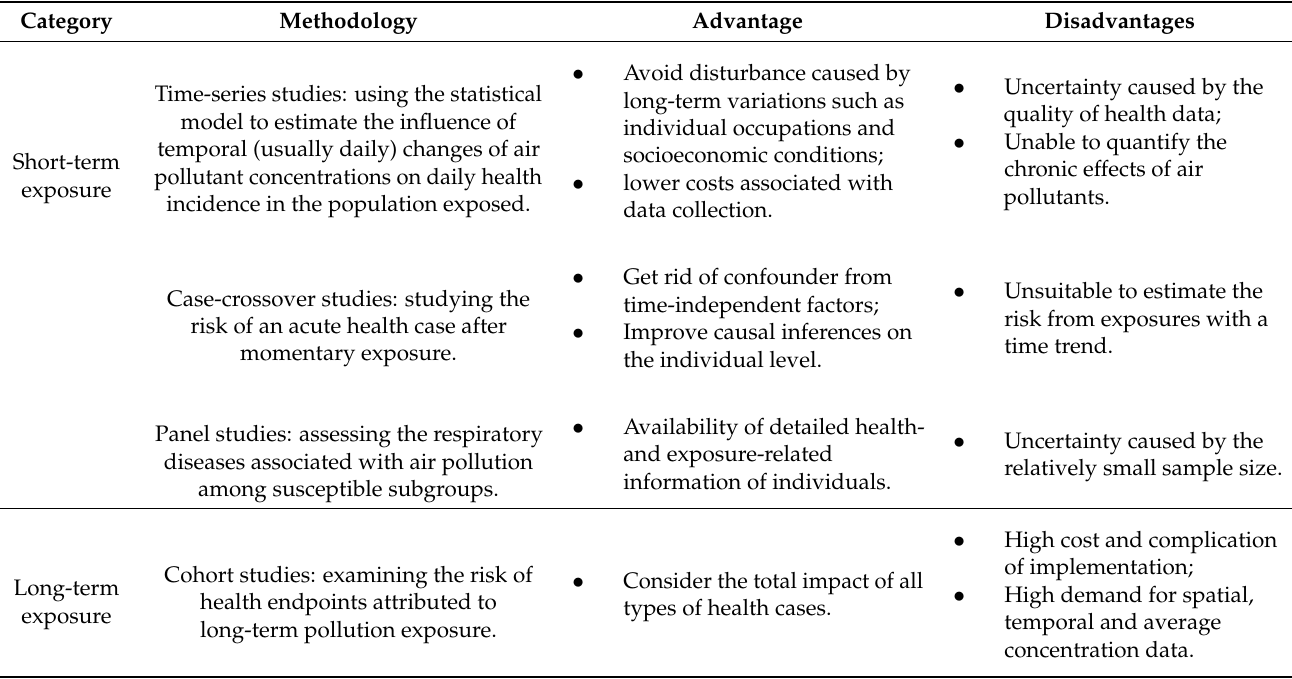
Table 3. Epidemiological studies of short- and long-term exposure and their features.